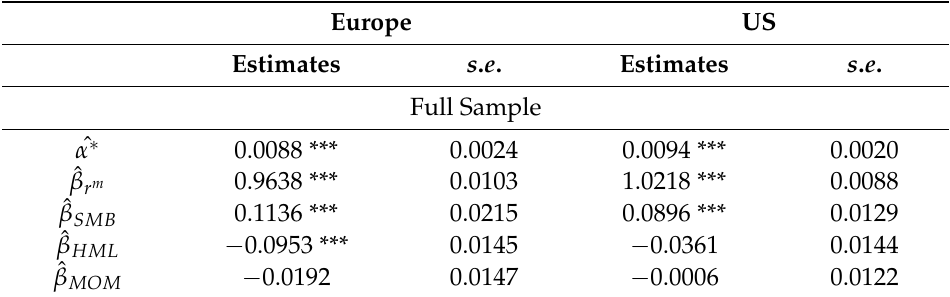
Table 12. Estimation of the augmented nonlinear panel version of Carhart’s model